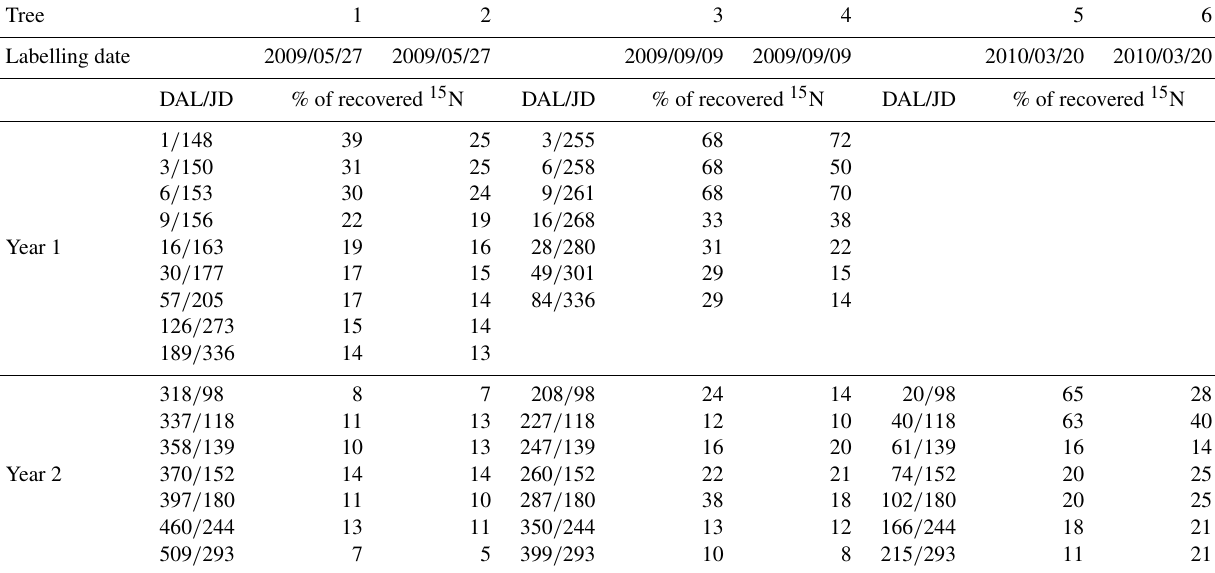
Table 1. Labelling characteristics and recovery of 15 N administered in each labelling campaign from the sampled compartments of each tree, on each sampling occasion (DAL: days after labelling, JD: Julian day number).